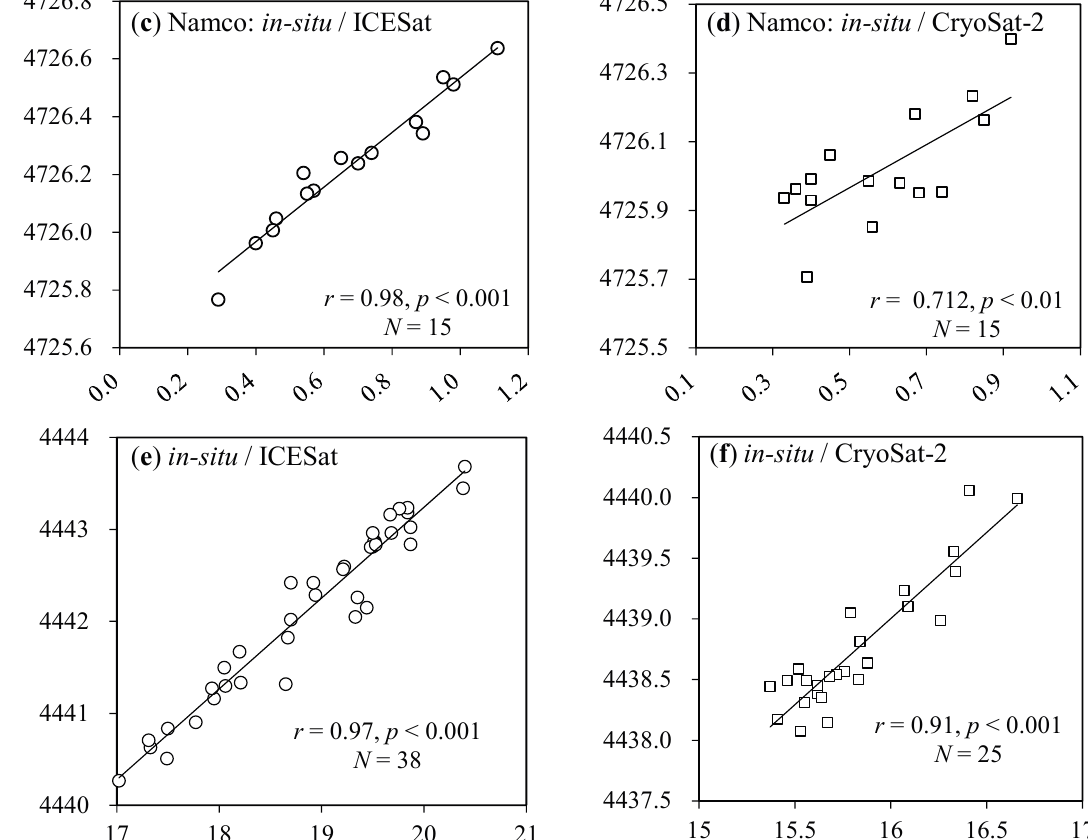
Figure 2. Evaluation of satellite altimetry measurements with in situ lake level data for Namco, and Yamzhog Yumco. Plots ( a , b ) Comparison of time series of combined ICESat/CryoSat-2/ in situ lake levels; scatter plots ( c – f ) comparisons of paired (sampled in the same date) in situ water level ( x -axis: m) and ICESat/ CryoSat-2 altimetry measurements ( y -axis: